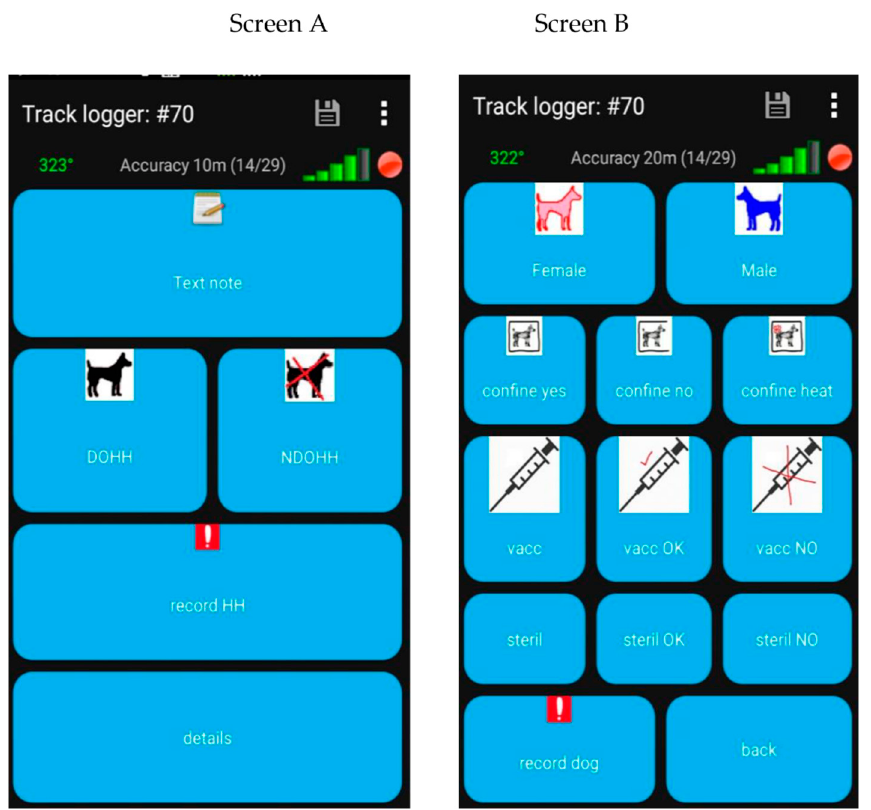
Figure 1. Screenshots of OSM Tracker application with modified layout showing icons-based screen used in shorter version to conduct household surveys at all the